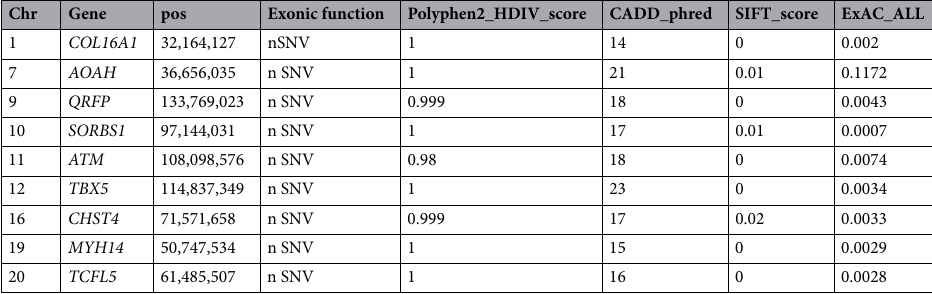
Table 3. Nominally significant genes from univariate analysis. Nonsynonymous SNV (nSNV).